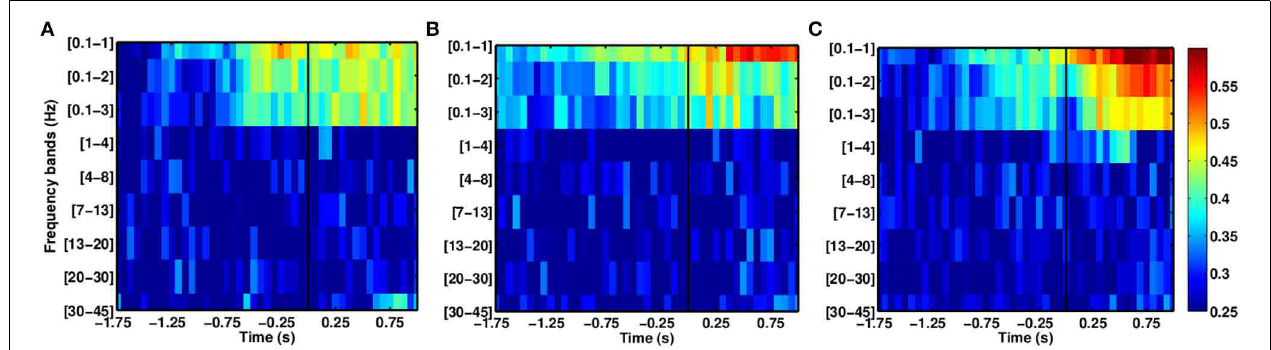
FIGURE 7 | The use of instantaneous phase features across frequency bands for able-bodied subjects (first row: C1, second row: C2).